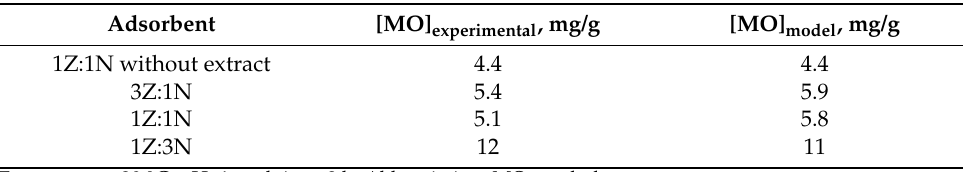
Table 1. Dye uptakes onto the various adsorbents